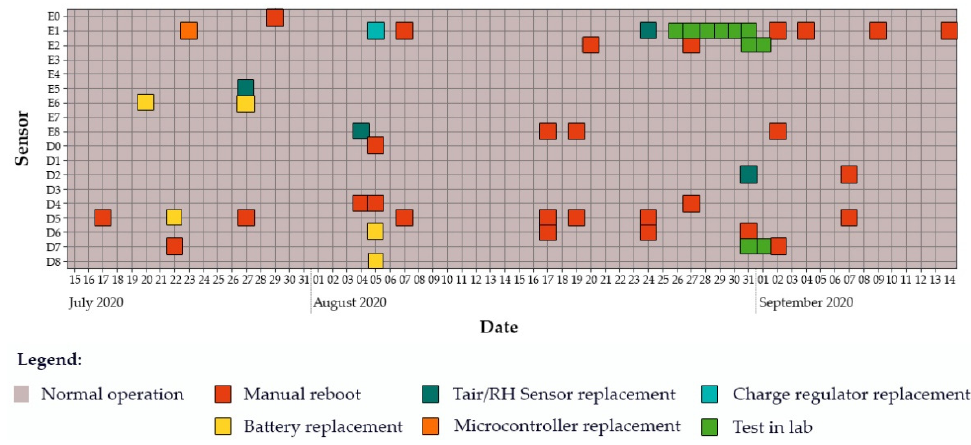
Figure 7. Maintenance interventions on the WSN sensor nodes in the period from July 15th to Sep-